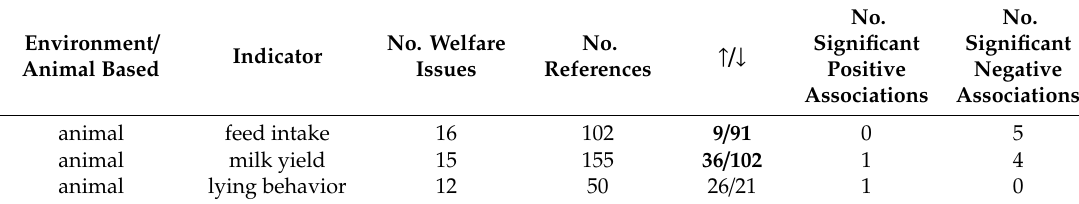
Table 2. Indicators that are associated with four or more welfare issues, ranked according to the number of welfare issues they were reported to have associations with. No. references refers to the total number of references reporting an association for each indicator. ↑ / ↓ indicates the total number of references indicating a positive association versus the total number of references indicating a negative association. Significant di ff erences between the number of positive and negative associations are highlighted in bold (binomial test, p < 0.05). No. significant positive / negative associations refers to the number of welfare issues that show either a significant (binomial test, p < 0.05) positive or negative association with each indicator. This number can be derived from Tables S2 and 3 where significant associations between welfare issues and indicators are highlighted in